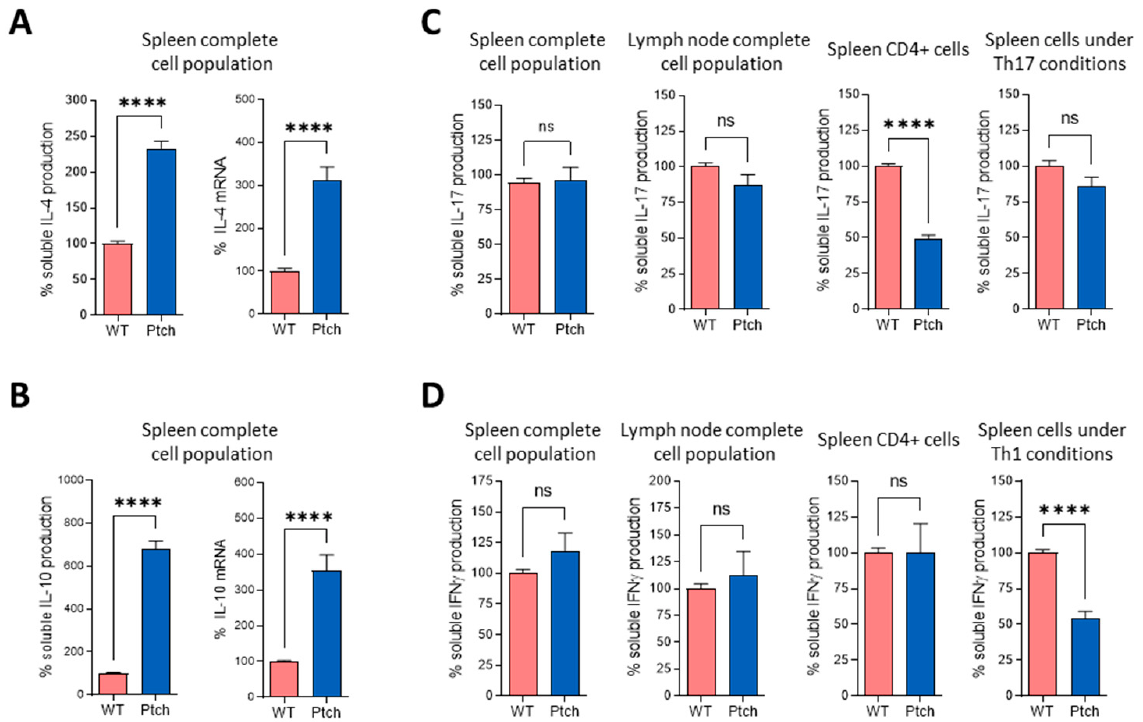
Figure 3. Cytokine profile of T lymphocytes from ptch +/ − and wt mice after a second round of TCR stimulation. Total-cell populations from spleen or LN or purified spleen CD4 + cells from ptch +/ − and wt mice were stimulated in vitro by using α CD3/ α CD28. After three days of culture, cells were subjected to a second round of α CD3/ α CD28 for another three days. Soluble IL-4 ( A ), IL-10 ( B ), IFN γ ( C ) and IL-17 ( D ) in the supernatants were measured by using ELISA. IL-4 ( A ) and IL-10 ( B ) mRNA were quantified by using RT-PCR. The results are represented as percentages of the values found for wt mice. Data are the mean of four independent experiments in which each sample was assayed in quadruplicate. Each sample corresponds to a pool of spleen or LN cells from four mice. Standard errors of the means are shown. Statistical significance is indicated as **** p < 0.0001 and ns (not significant).